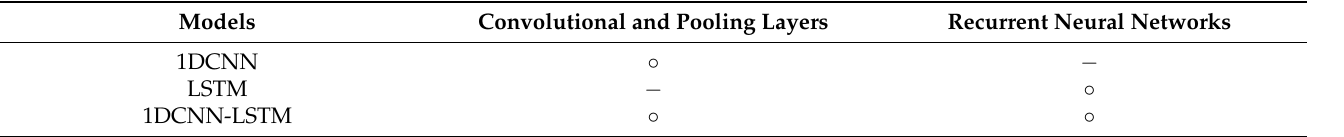
Table 1. Main differences in the structure of each model.